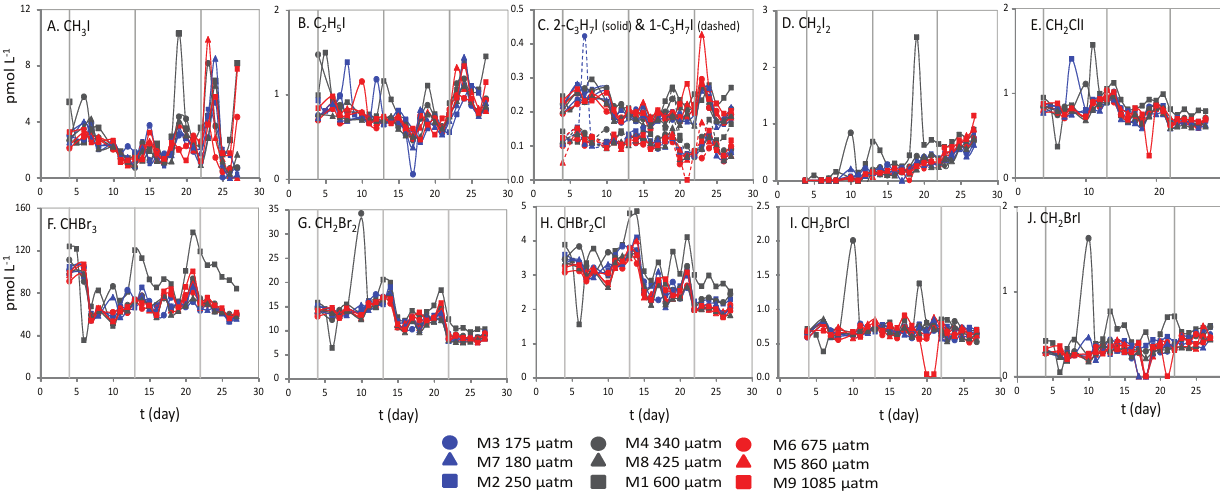
Fig. 2. Concentrations (pmolL − 1 ) of I-monohalocarbons ( (A) CH 3 I, (B) C 2 H 5 I and (C) 2-C 3 H 7 I (solid) and 1-C 3 H 7 I (dashed)), I- polyhalocarbons ( (D) CH 2 I 2 , (E) CH 2 ClI) and Br-polyhalocarbons ( (F) CHBr 3 , (G) CH 2 Br, (H) CHBr 2 Cl, I. CH 2 BrCl (J) CH2BrI). Grey lines indicate phases of the experiment: PI t 4 – t 12 , PII Days t 13 – t 21 , PIII Days t 22 – t 30 . p CO 2 (µatm) shown in the legend are averages for period t 8 – t 27